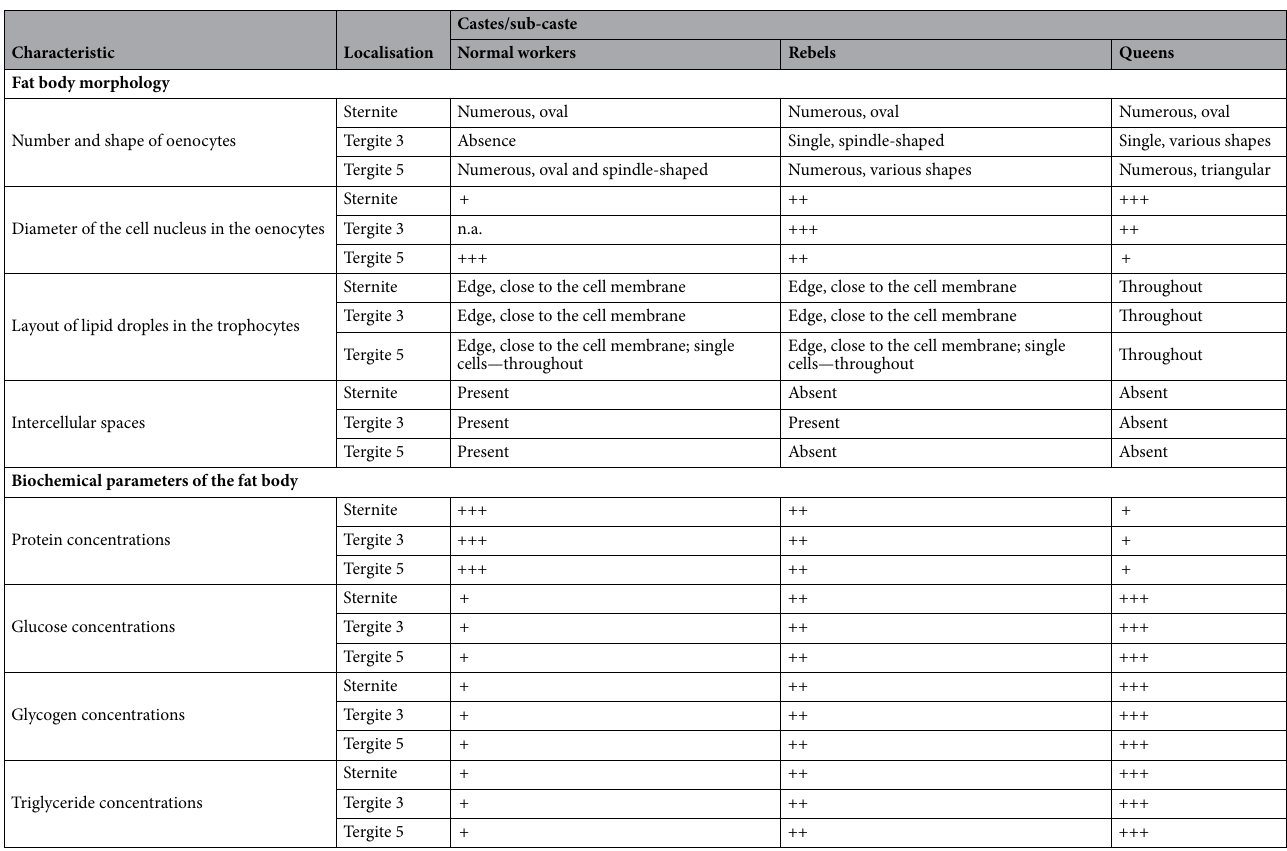
Table 1. Similarities and differences in the morphology and biochemical characteristics of the fat body between the queens, rebels and normal workers. + low values; ++ intermediate values; +++ high values; n.a.— not applicable; Tergite 3—the third tergite; Tergite 5—the fifth tergite.